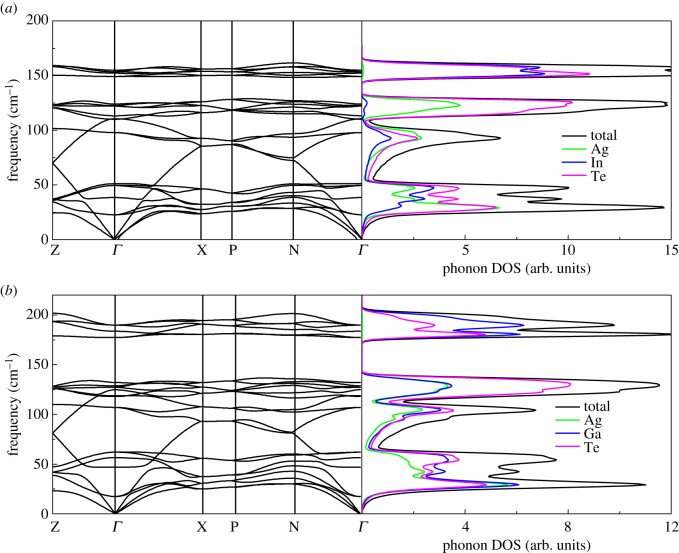
Calculated phonon dispersion curves and projected phonon DOS for (a) AgInTe2 and (b) AgGaTe2.